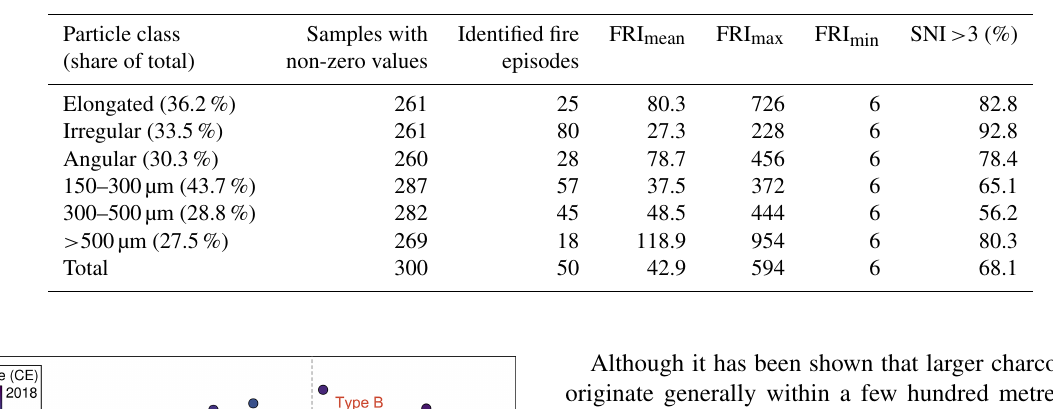
Table 2. Reconstructed fire episodes, fire return interval (FRI) in years, and distributions of signal-to-noise index (SNI) > 3 for charcoal morphotype and size classes, as well as the sum of charcoal particles over the last two millennia.